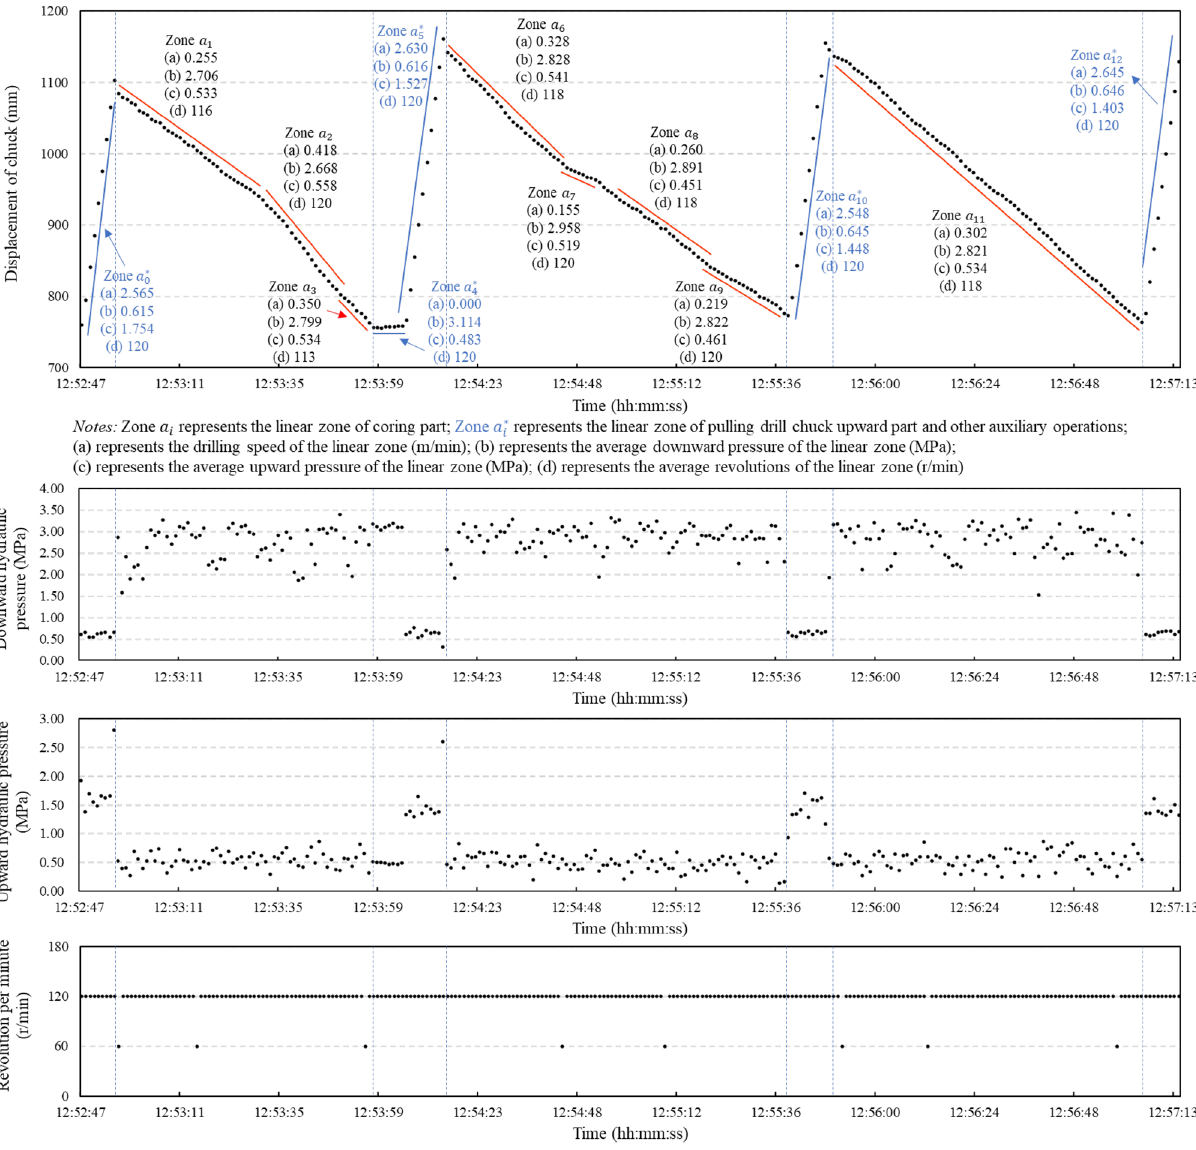
Figure 3. Real-time factual data for the drilling process of hydraulic rotary coring along this